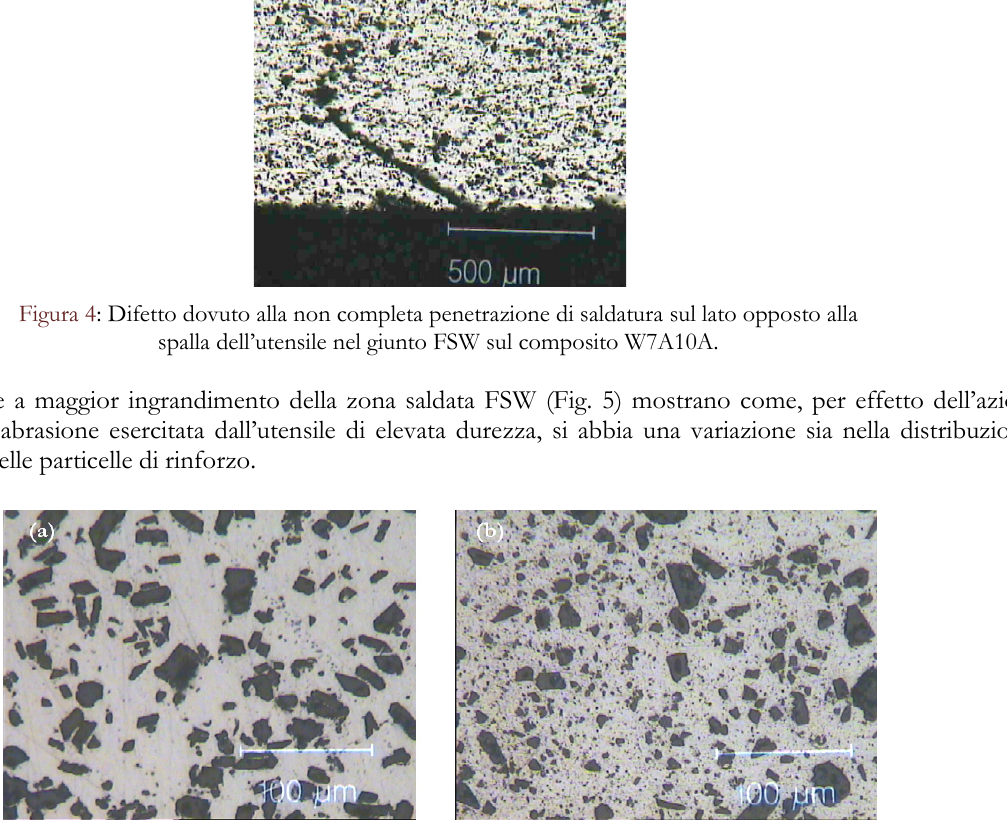
Figura 5: Micrografie ottiche del composito W6A20A: (a) materiale base; (b) centro del cordone FSW.